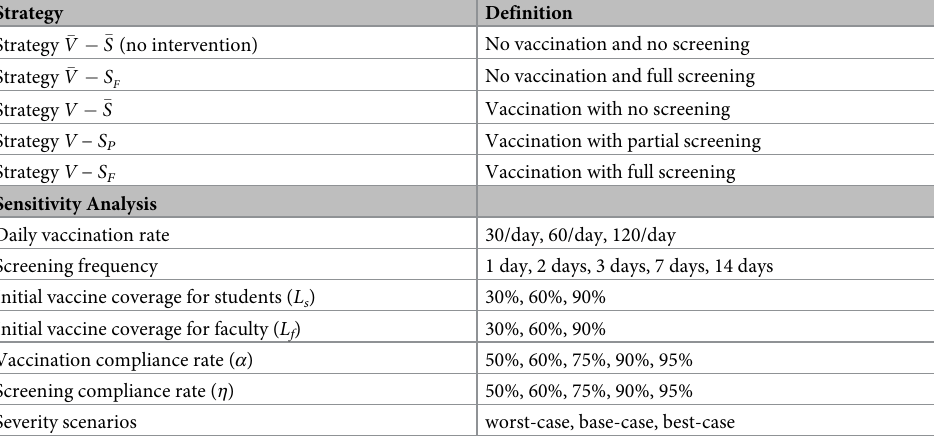
= � S denotes partial/full/no F